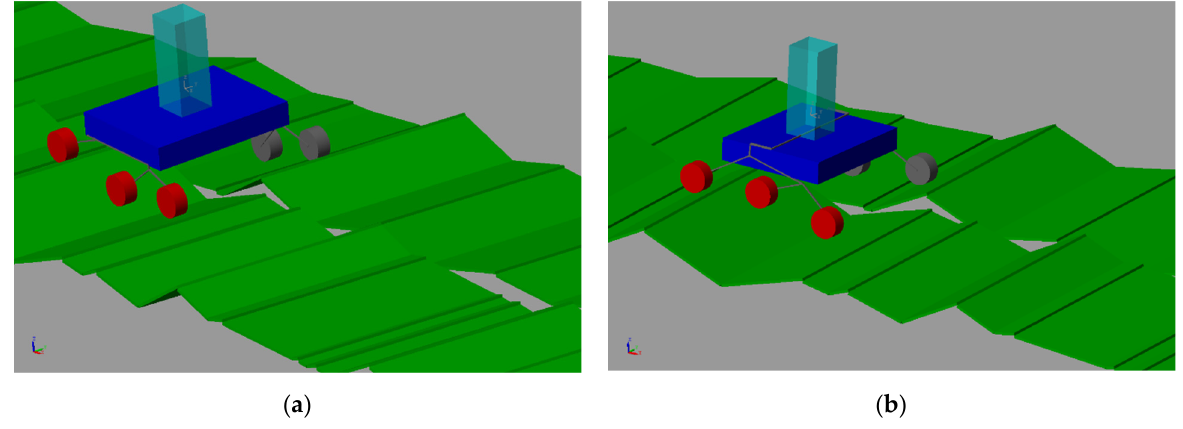
Figure 8. Direct dynamics simulation on rough soil: ( a ) LSR; ( b ) RBR.